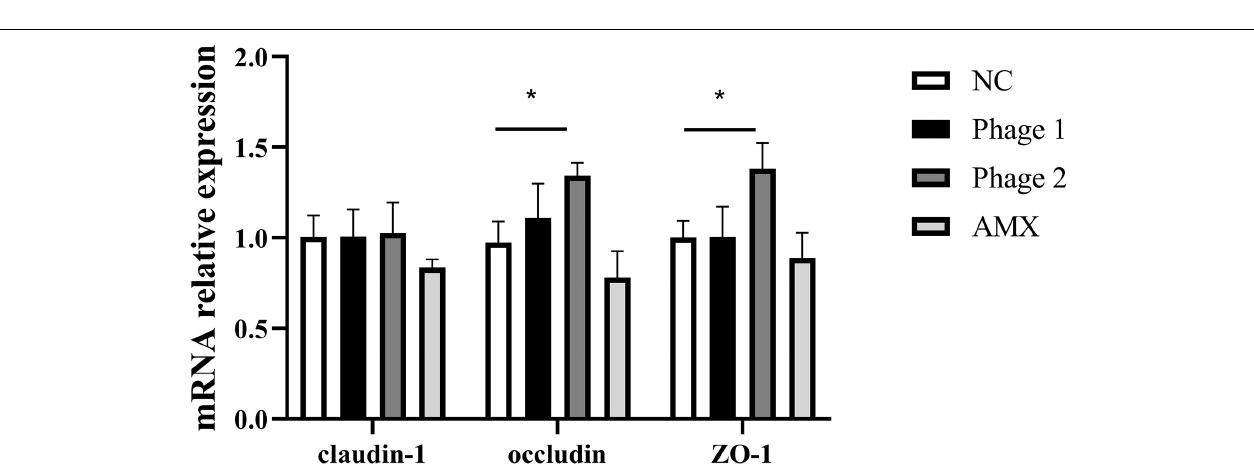
FIGURE 3 | Effect of phages on the relative mRNA expression of the jejunal tight junction. Fold induction of relative mRNA expressions of claudin-1, occludin, and ZO-1 ( n = 5). NC, negative control; Phage 1, 10 9 PFU GRNsp6 (day 3-5); Phage 2, 10 9 PFU GRNsp6 (day 8-10); AMX, 1 mg/ml amoxicillin (day 8-10). * p < 0.05.